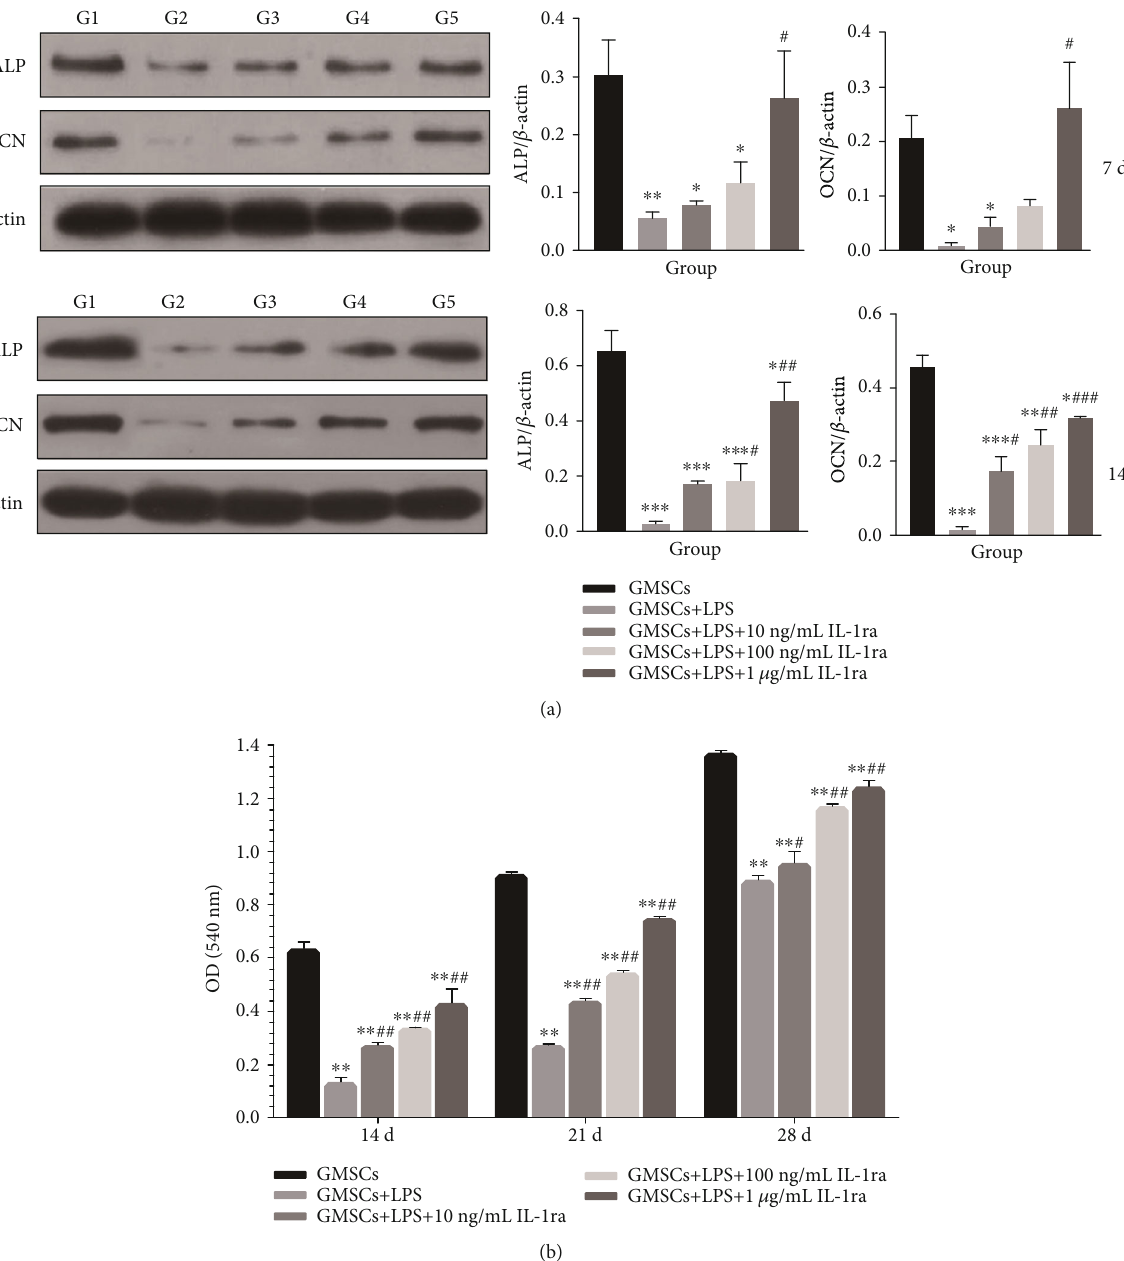
Figure 8: rGMSC osteogenic gene expression on protein level and calci fi ed nodule deposition. (a) Expression of osteogenic-related proteins ALP and OCN in rGMSCs after 7 days and 14 days of osteogenic induction, detected by western blot (G1: GMSCs; G2: GMSCs+LPS; G3: GMSCs+LPS+10ng/mL IL-1ra; G4: GMSCs+LPS+100ng/mL IL-1ra; and G5: GMSCs+LPS+1 μ g/mL IL-1ra). (b) Mineralized nodule formation by rGMSCs after 14 days, 21 days, and 28 days of osteogenic induction, detected by Alizarin Red staining. ∗ P < 0 : 05 , ∗∗ P < 0 : 01 , and ∗∗∗ P < 0 : 001 vs. GMSCs; # P < 0 : 05 , ## P < 0 : 01 , and ### P < 0 : 001 vs.